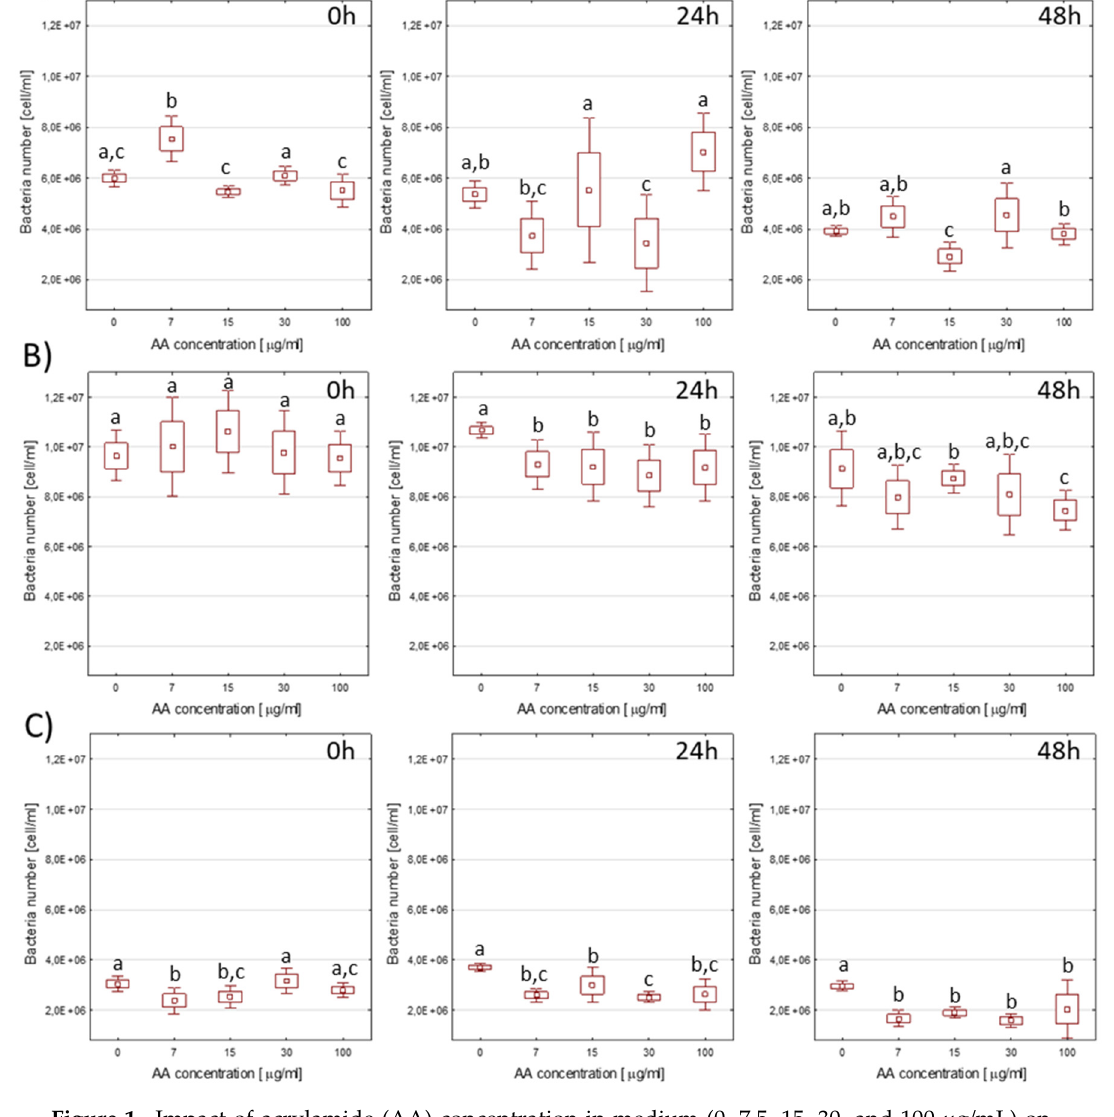
Figure 1. Impact of acrylamide (AA) concentration in medium (0, 7.5, 15, 30, and 100 µg/mL) on bacterial cell number in culture (cells/mL) determined by cytometric method immediately after AA addition and after 24 h and 48 h incubation. ( A ) L. acidophilus LA-5, ( B ) L. brevis, ( C ) L. plantarum . Values in graphs with different letters differ from each other at the level of p < 0.05 (Tukey’s HSD test).